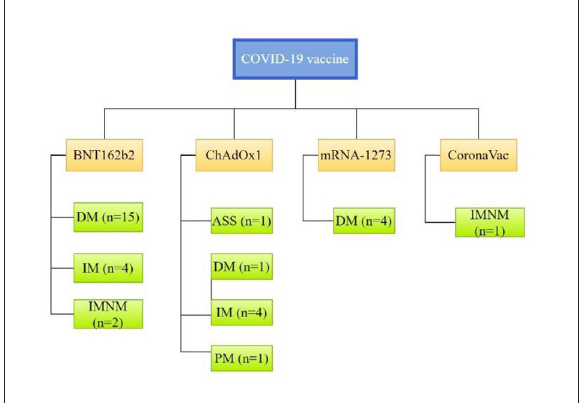
FIGURE2 Clinical subtypes of myositis associated with individual CoV-19 vaccines. ASS, anti-synthetase syndrome; DM, dermatomyositis;